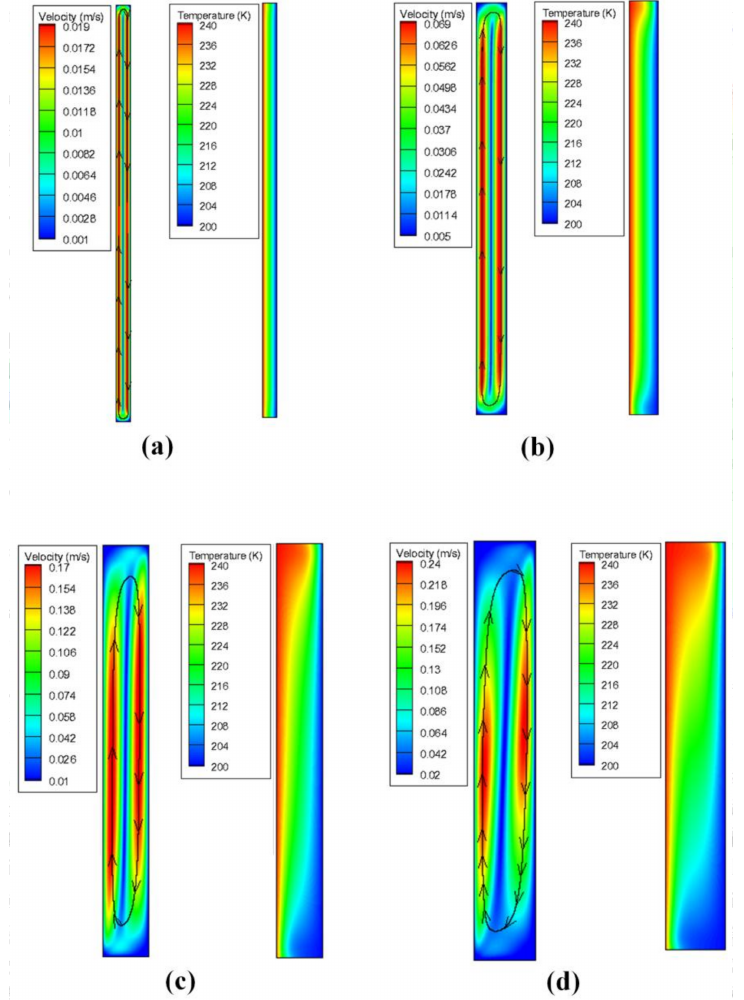
Figure 10. Velocity and temperature fields in the vertical enclosures at L = 1000 mm, ∆ T = 40 K: ( a ) H = 40 mm; ( b ) H = 80 mm; ( c ) H = 130 mm; ( d ) H = 170